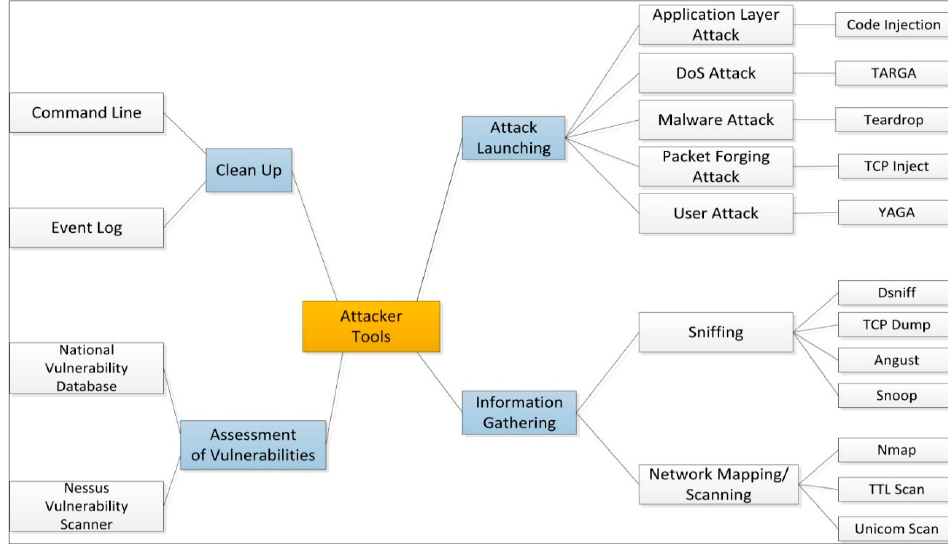
Figure 4. Common tools used by attackers.